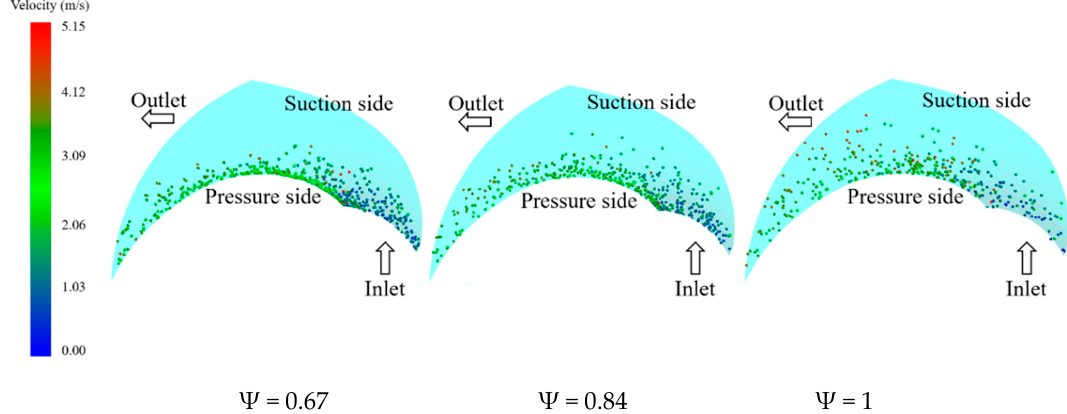
Figure 16. Distributions of the particles of different shapes in one flow passage of the pump impeller.